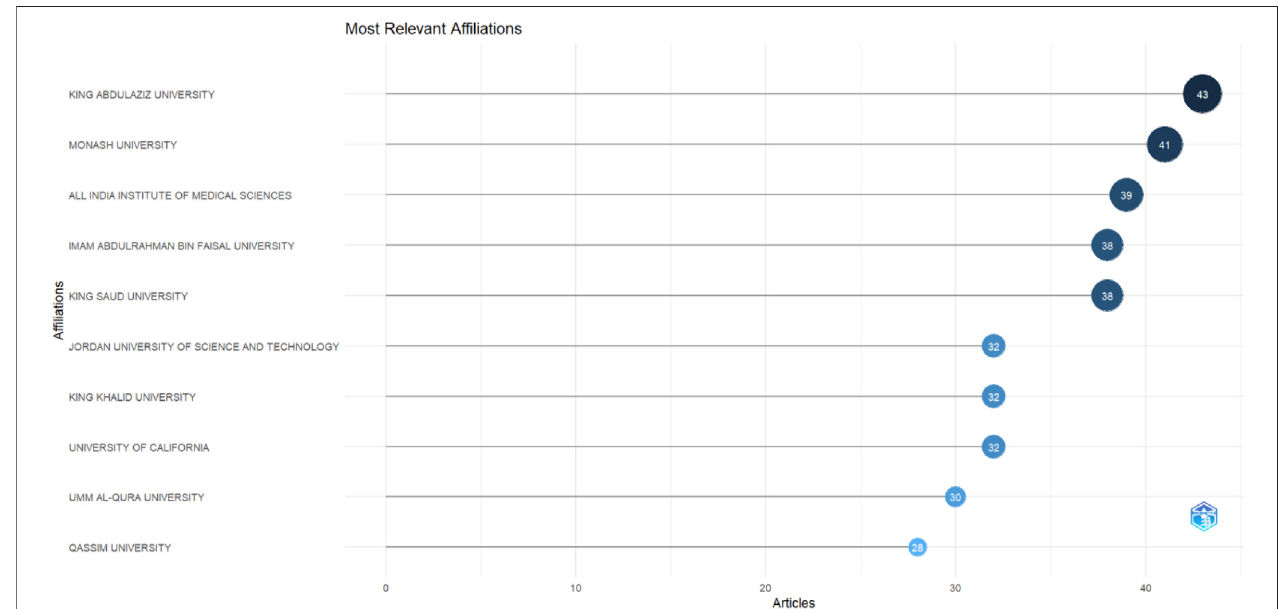
FIGURE 7 | Relevant institutions.